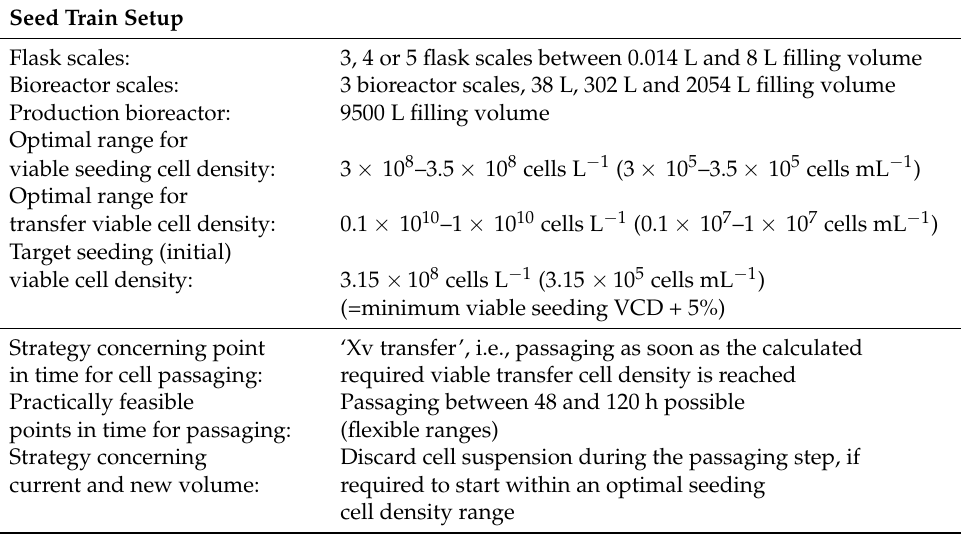
Table 1. Specification of the exemplary seed train setup providing information concerning cultivation vessels, required viable cell densities and the transfer of cells from one cultivation vessel into the next larger one, assumed in this work.